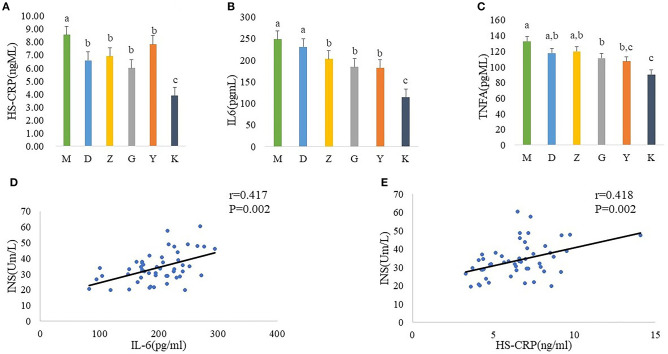
Plasma concentration of HS-CPR (A), IL-6 (B), and TNF-α (C) in model control group (M), low dose of Guizhi Fuling Wans (L), middle dose of Guizhi Fuling Wans (Z), high dose of Guizhi Fuling Wans (G). Different superscript letters indicate significant differences (P < 0.05) in data according to Kruskal-Wallis and the post-hoc ANOVA statistical analysis. Correlation analysis between inflammatory cytokines and fasting insulin: A positive correlation can be seen between inflammatory cytokines (IL-6, HS-CRP) and INS (D,E). The “r” refers to the Spearman correlation coefficient, and the P < 0.05 indicate differences are significant.